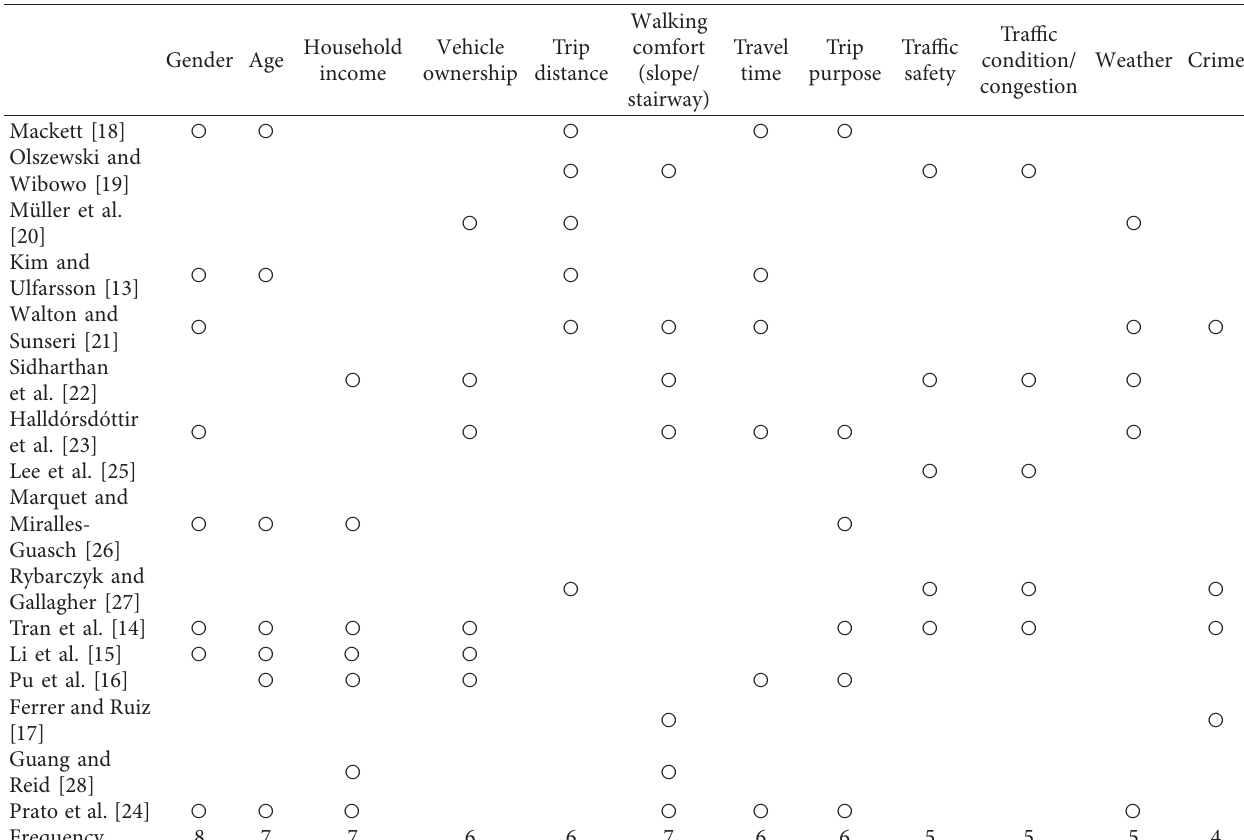
Table 3: Factors considered in previous studies of a short-distance trip.